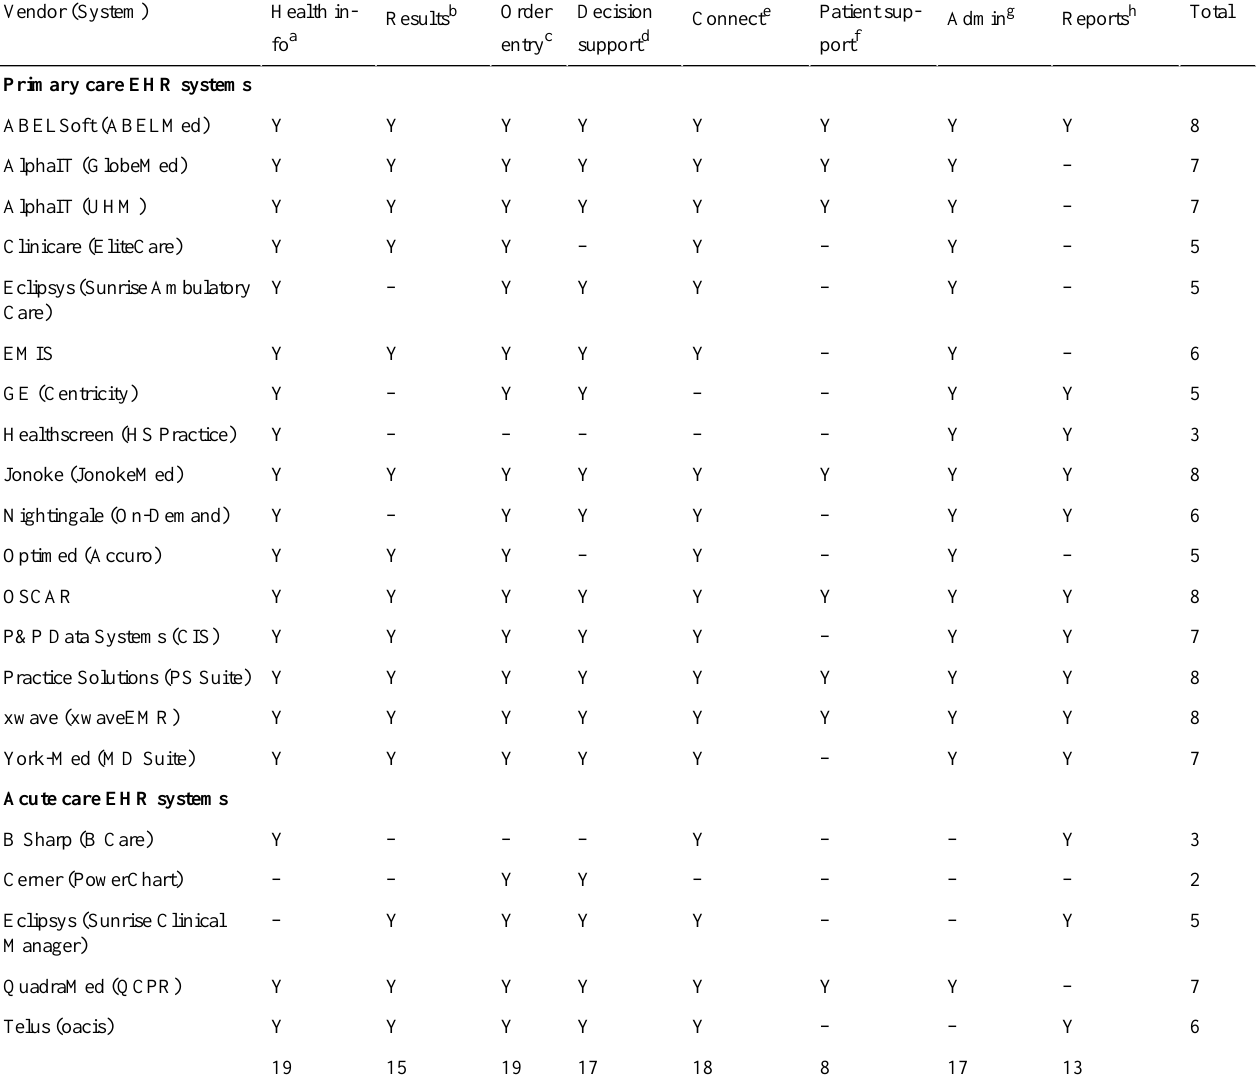
Table 2. Core functionalities of EHRs presented on websites (Y=website contains the feature).